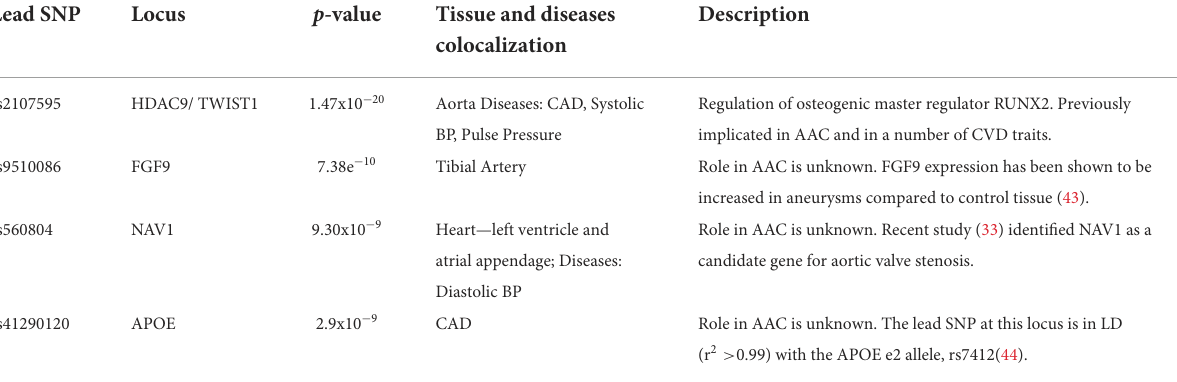
TABLE 2 Summary of genome-wide significant associations identified in a metaanalysis of 31,786 UK Biobank participants and 9,417 CHARGE participants. Lead